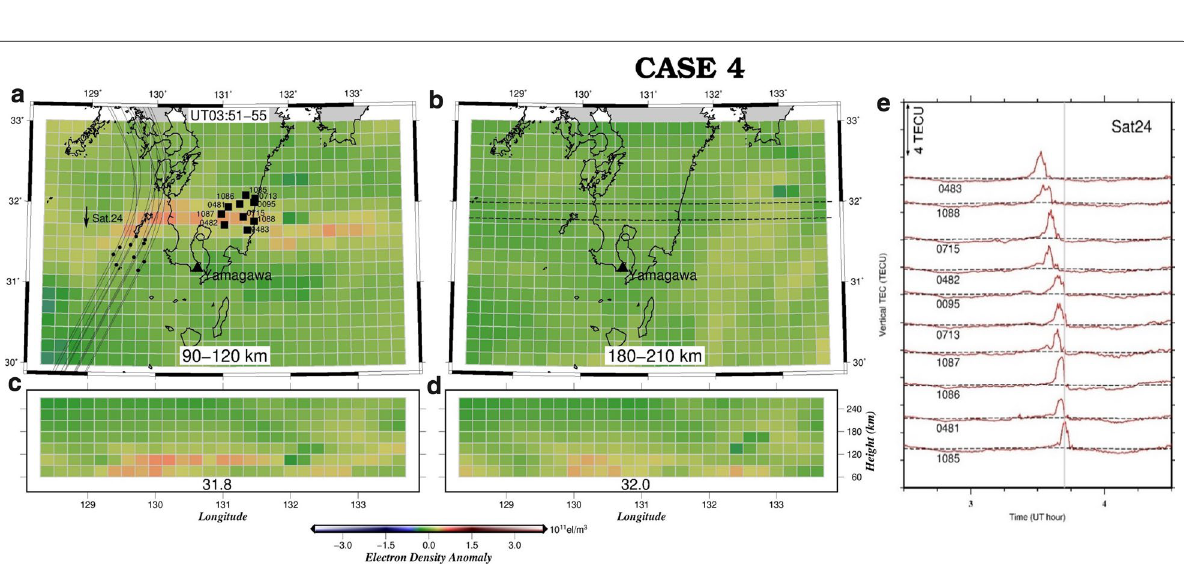
Fig. 7 Results of 3D tomography (average of 3:51, 3:53, 3:55 UT) of Case 4 Es patch on May 22, 2010, above the Kyushu District (Maeda and Heki 2015). Black curves in a describe the tracks (moving southward) of the intersection of LoS with a thin layer at 100-km altitude (black dots show the positions at 3:51 UT) for the station–satellite pairs shown in e . We show the map views of the results at altitudes 90–120 km ( a ) and 180–210 km ( b ), and latitude–height profiles at 31.8° N ( c ) and 32.0° N ( d ). Time series (red curves) showing vertical TEC changes 2.5–4.5 UT as residuals from refer- ence curves, observed at ten stations (black rectangles in a ), using GPS satellite 24 ( e) . Clear Es signatures are seen 3.50–3.75 UT as positive